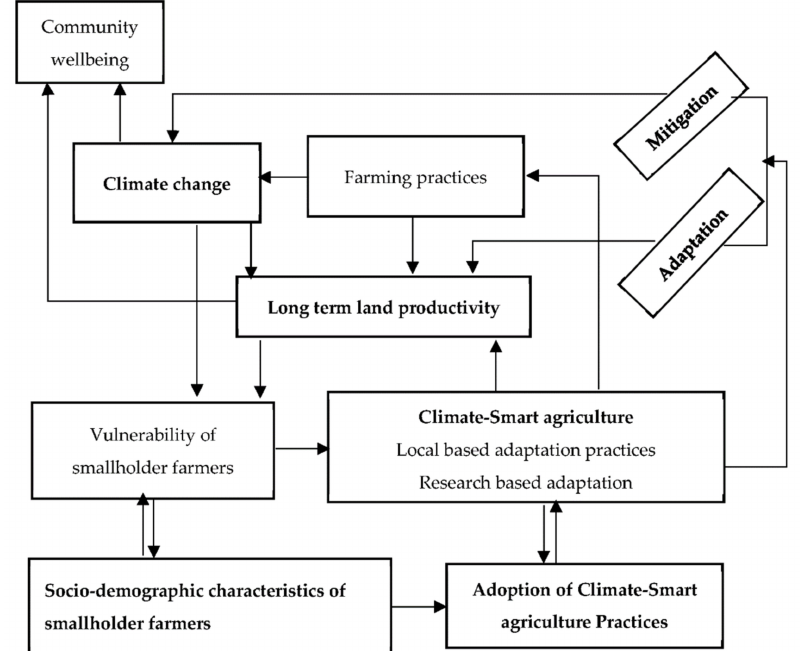
Figure 1. Conceptual framework showing presumed relationships between climate change, CSA and farmer’s perception and adoption of CSAP. Sources: